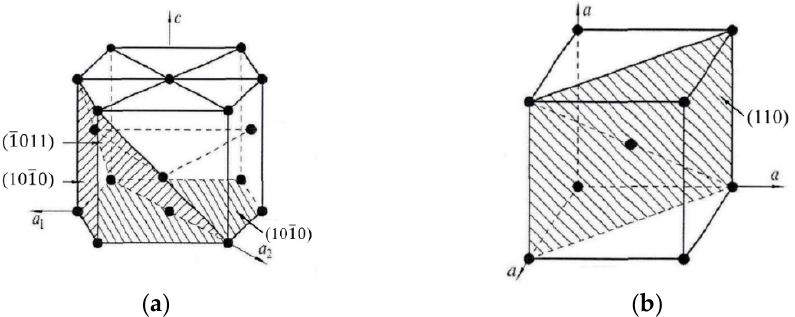
Figure 3. Schematic diagram of the crystal structures of α -Ti and β -Ti. ( a ) α -Ti. ( b ) β -Ti.